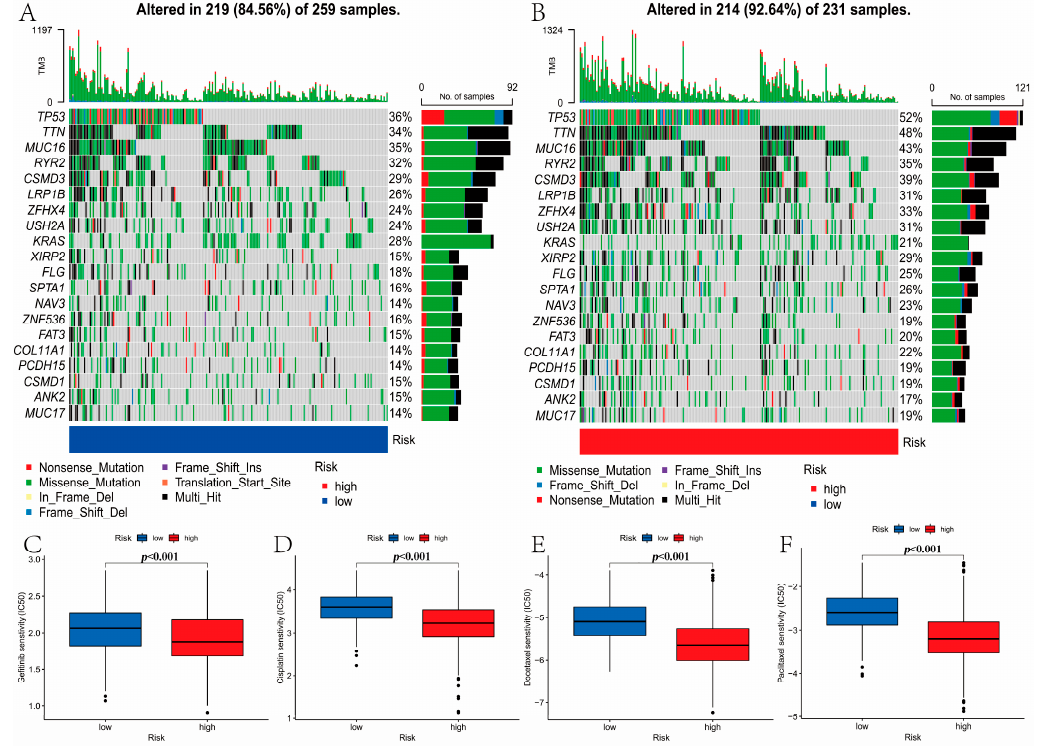
Figure 9. Mutation and drug susceptibility analysis. The waterfall plot of somatic mutation features established with low-risk groups ( A ) and high-risk groups ( B ). The frequency of gene mutation was lower in the low-risk group. ( C – F ) The patients in the high-risk group had lower IC50 value in these drugs: ( C ) Gefitinib, ( D ) Cisplatin, ( E ) Docetaxel, and ( F ) Paclitaxel.